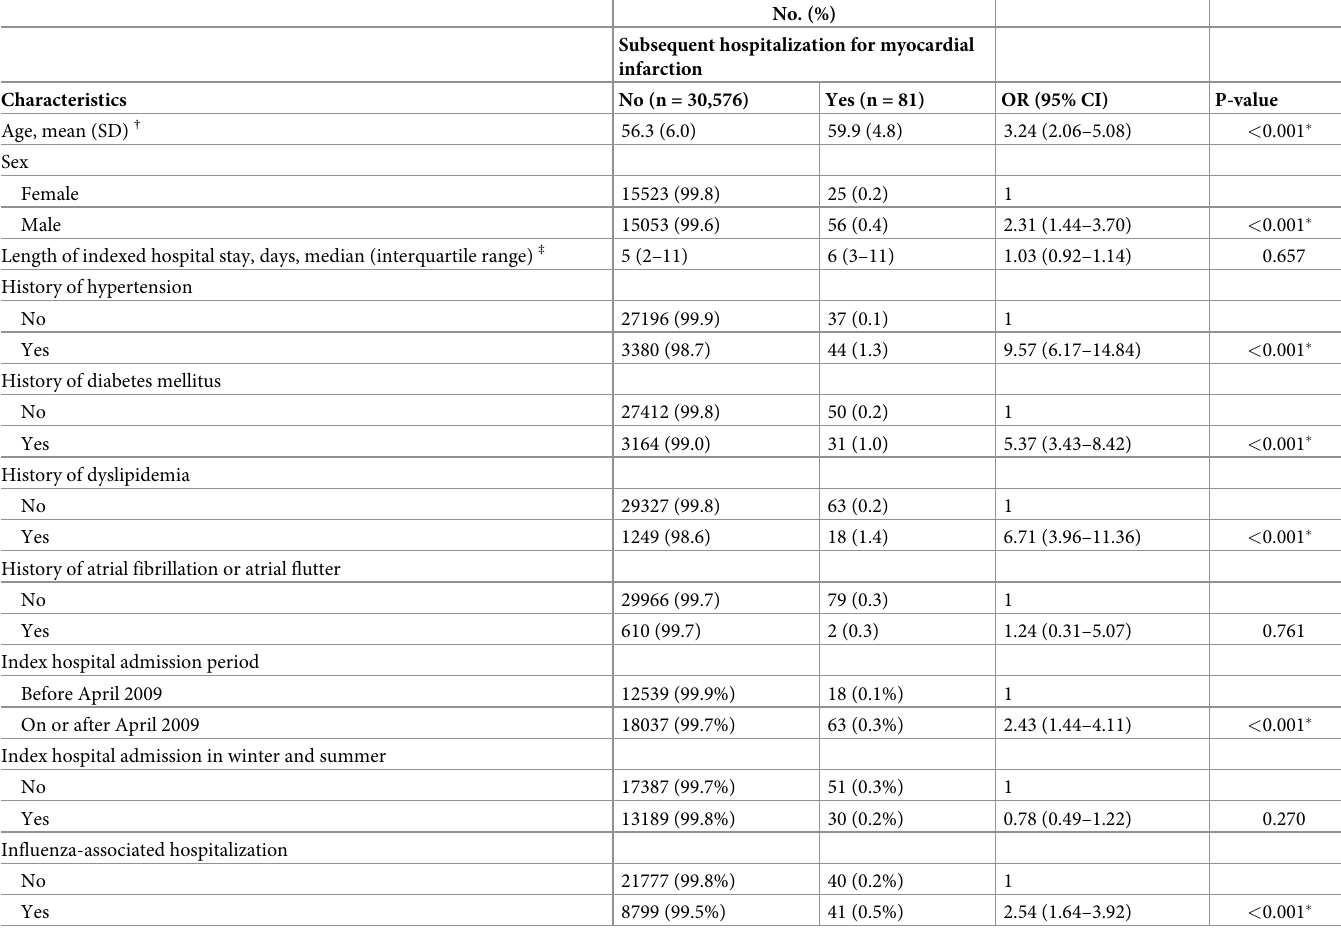
OR, odds ratio; CI, confidence interval.